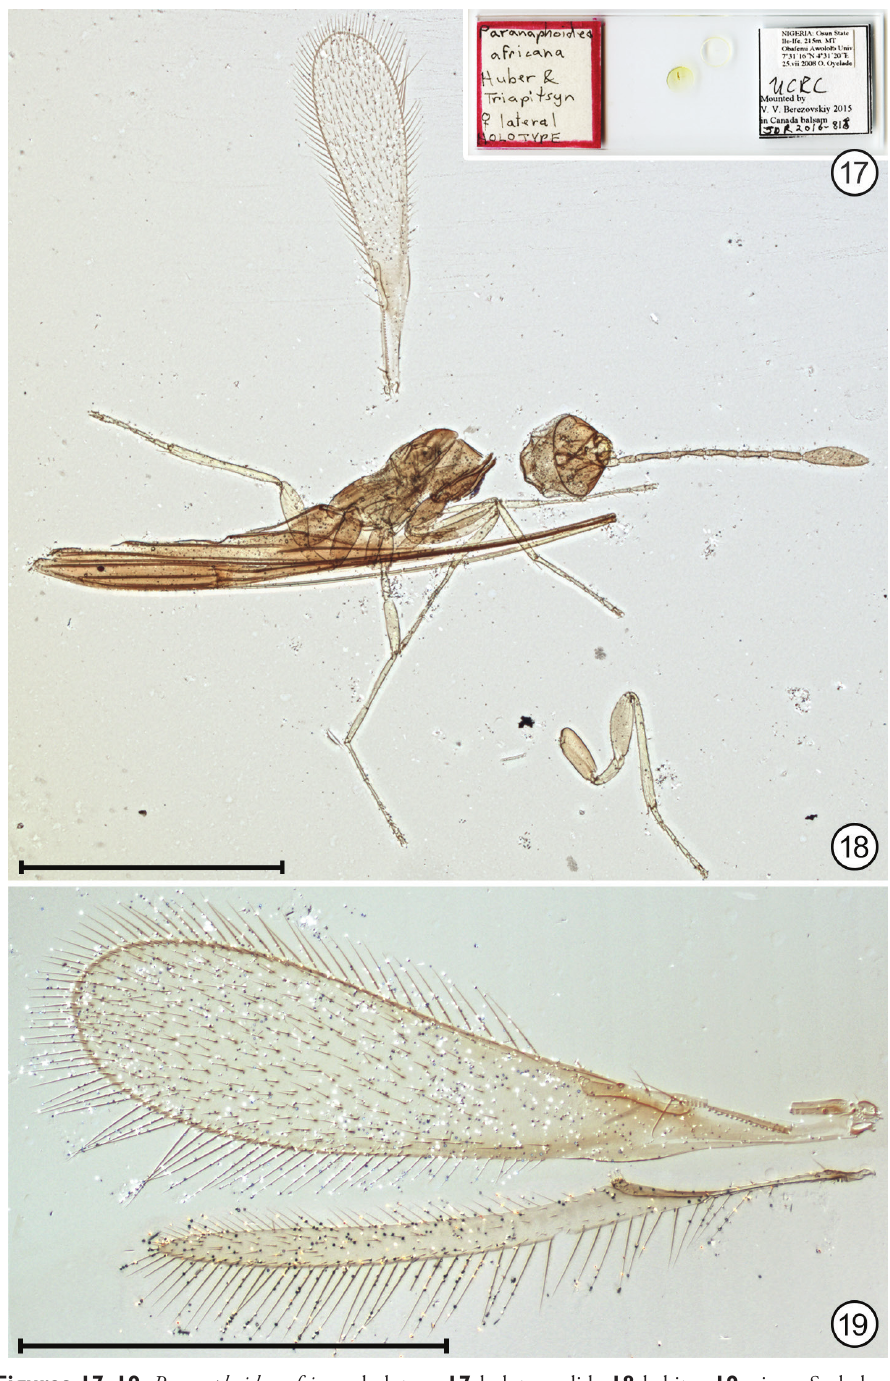
Figures 17–19. Paranaphoidea africana holotype 17 holotype slide 18 habitus 19 wings. Scale bars: 1000 μm ( 18 ), 500 μm ( 19